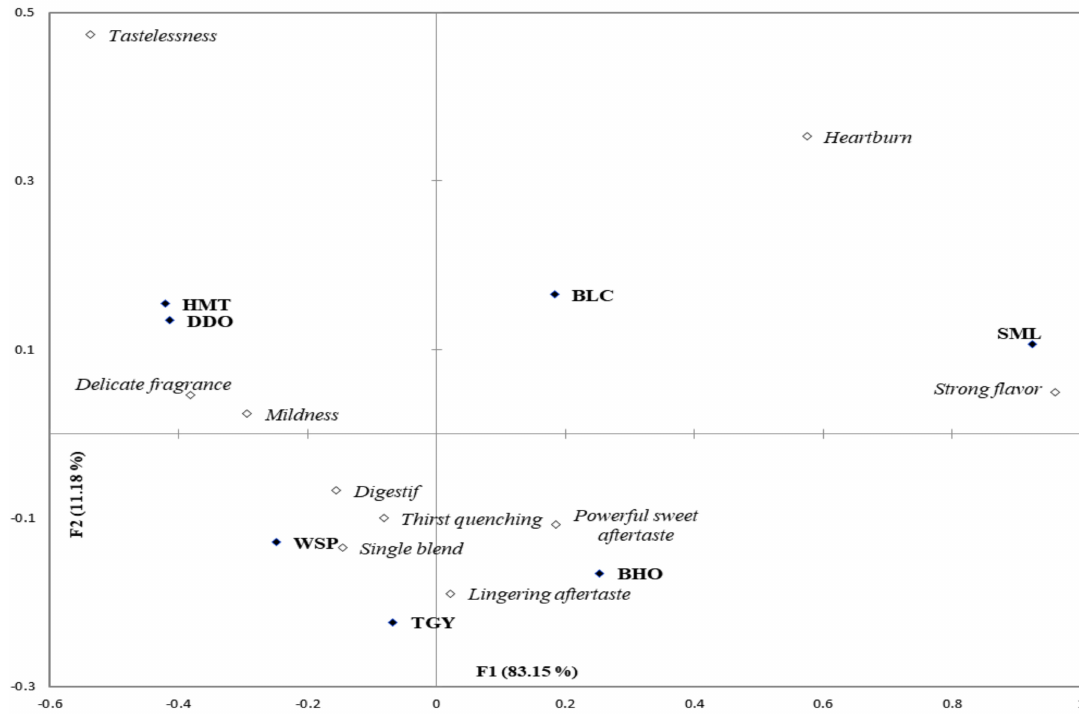
Figure 3. A bi-plot by correspondence analysis of the 7 tea infusions in association with the 10 postprandial perception attributes selected by more than 20% of participants. BLC: Bi-Luo-Chun green tea, WSP: Wenshan Pouchong tea, HMT: High-mountain oolong tea, DDO: Dong Ding oolong tea, TGY: Iron Goddess oolong tea, BHO: Baihao oolong tea and SML: Yuchi Sun-Moon-Lake black